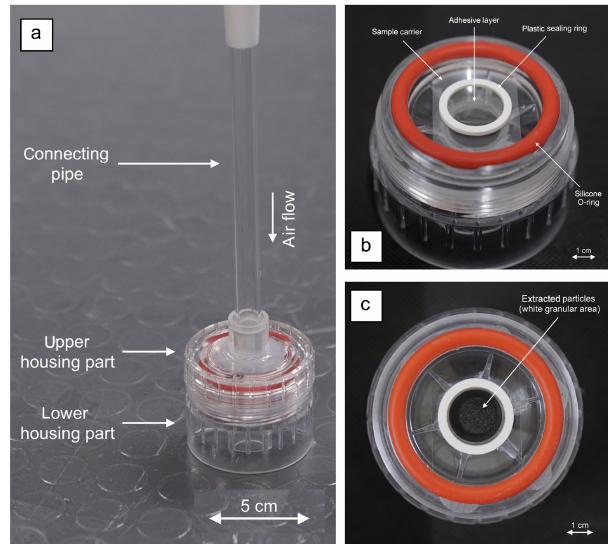
Figure 4. (a) Perspective view of the assembled particle extractor, with a connecting pipe to the bell mouth; (b) perspective view of the particle extractor with the upper housing part removed and the sample carrier installed; (c) top view of the particle extractor with the upper housing part removed and particle-loaded sample carrier; extracted particles are deposited in the area enclosed by the white plastic